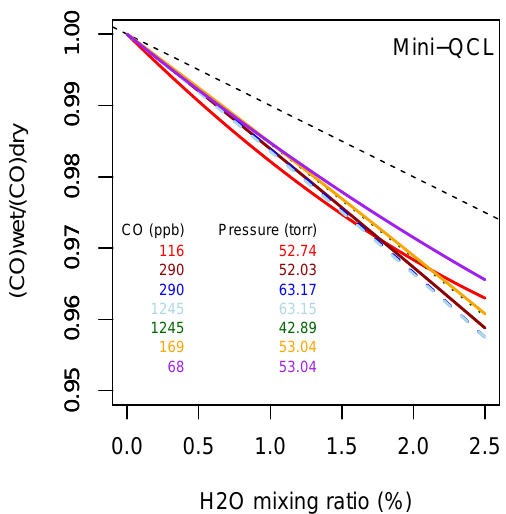
Fig. 11. Water vapour correction function for different CO mole fractions of the ICOS-QCL instrument (coloured lines) and the ef- fect of dilution (black dashed